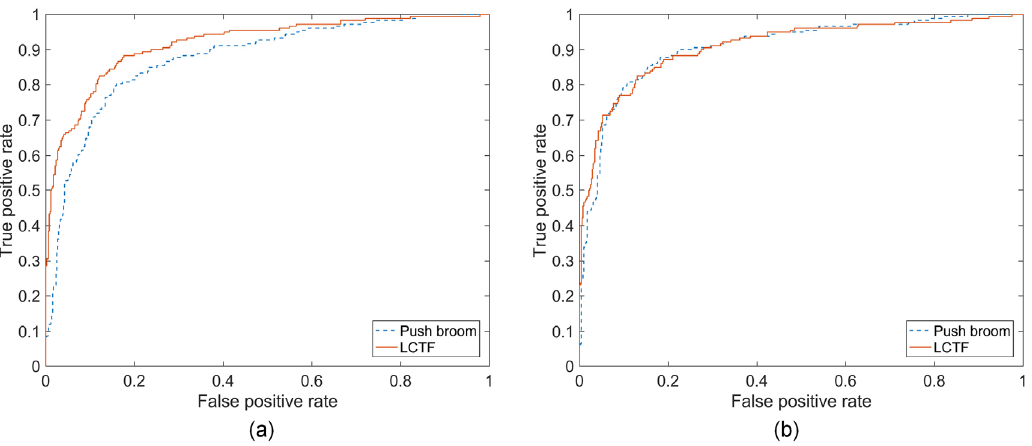
Figure 5. Receiver operating characteristics (ROC) curves of ( a ) PLS-DA and ( b ) SVM classifiers for blueberry bruise detection using mean reflectance from push broom based and LCTF based HSI.